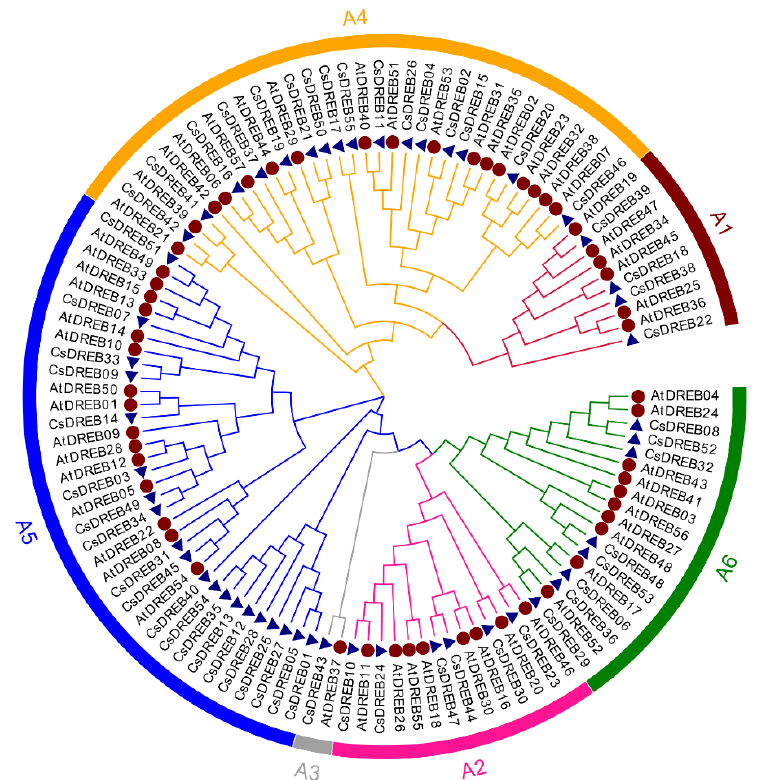
Figure 2. The phylogenetic tree of the DREB proteins from cucumber and Arabidopsis : Different colors represent different subgroups of the DREB family. The blue triangles and red circles represent DREB proteins of cucumber and Arabidopsis , respectively .